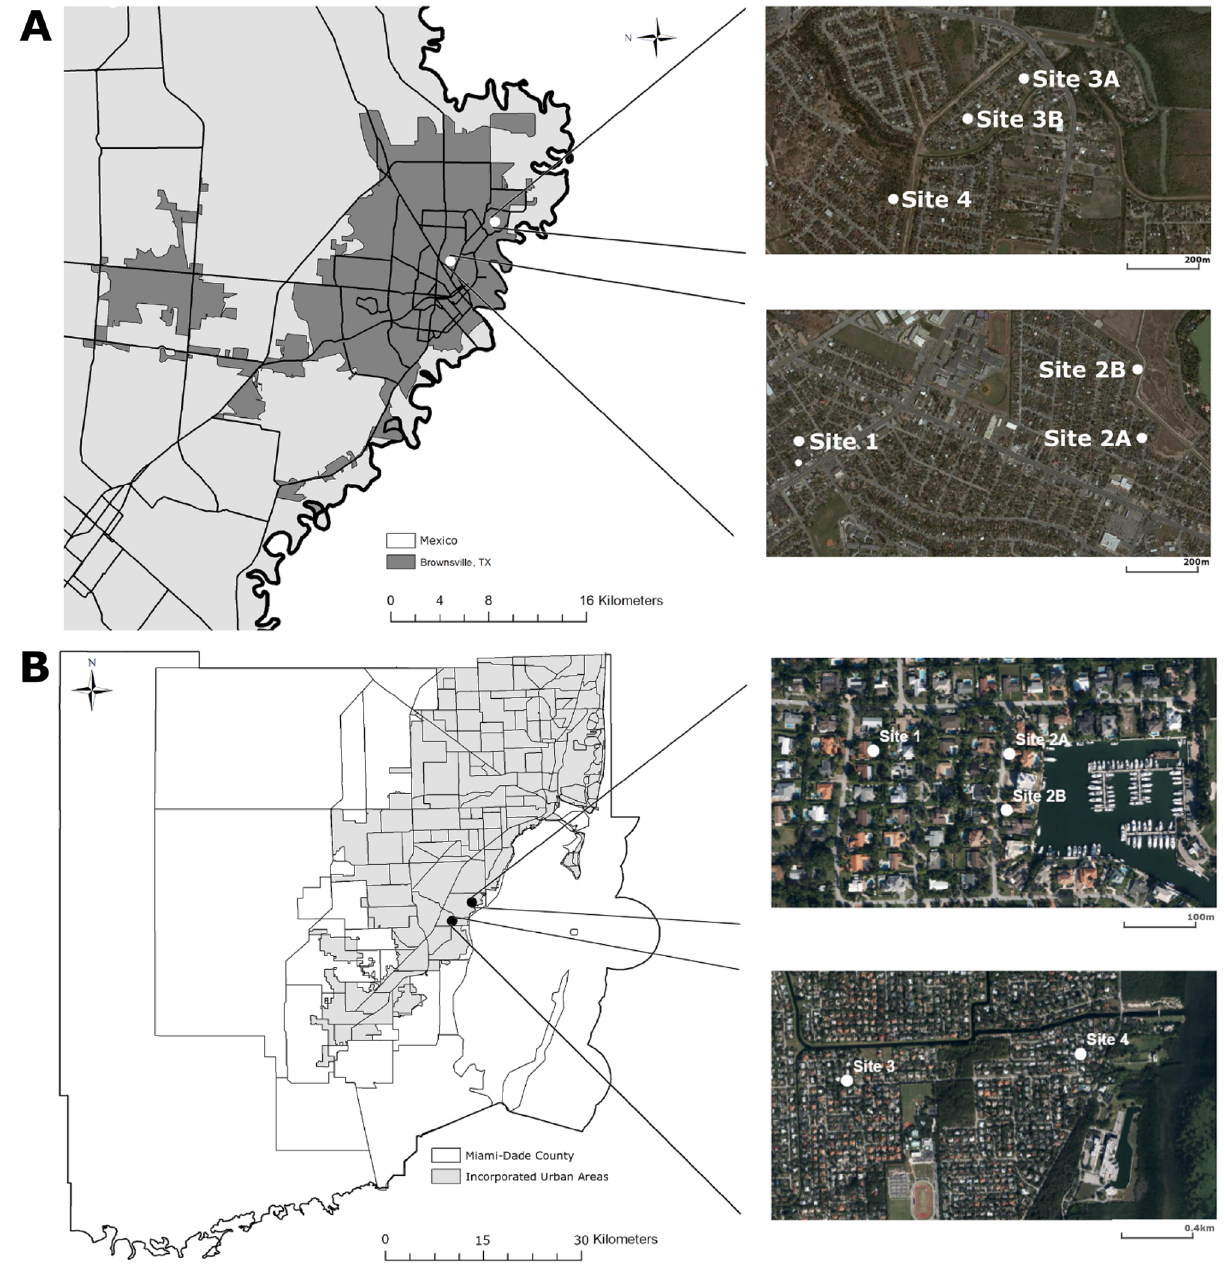
Figure 5. Maps of sampling sites in Brownsville, Texas ( A ) and Miami Dade County, Florida, ( B ). In Brownsville, the traps were moved from 2A to 2B and from 3A to 3B because mosquito caught dipped markedly at sites 2A and 3A. The traps were moved to the more productive sites 2B and 3B. In Miami, the trap was moved from site 2A to site 2B for the same reason as in Brownsville. The figure was produced using ArcGIS 10.2 (Esri, Redlands, CA), using freely available layers from the Miami-Dade County’s Open Data Hub—https:// gis- mdc. opend ata. arcgis.